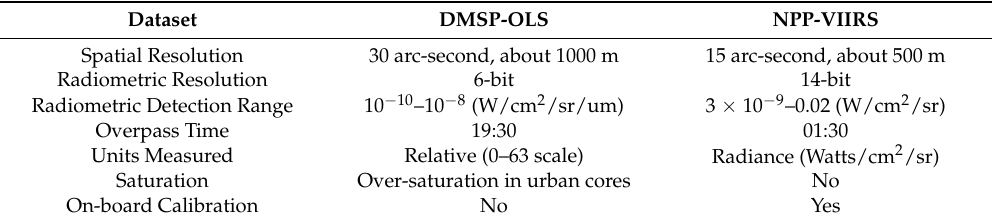
Table 1. The differences between raw DMSP-OLS and NPP-VIIRS